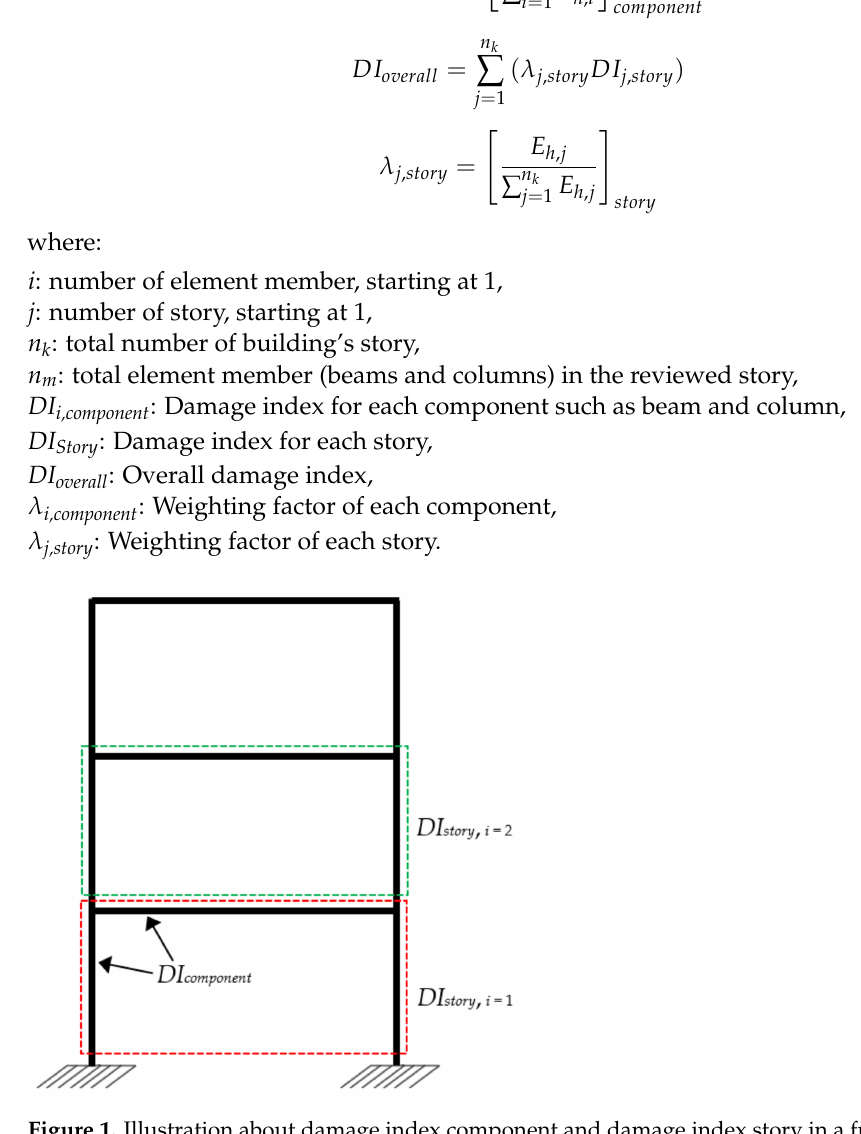
Figure 1. Illustration about damage index component and damage index story in a frame